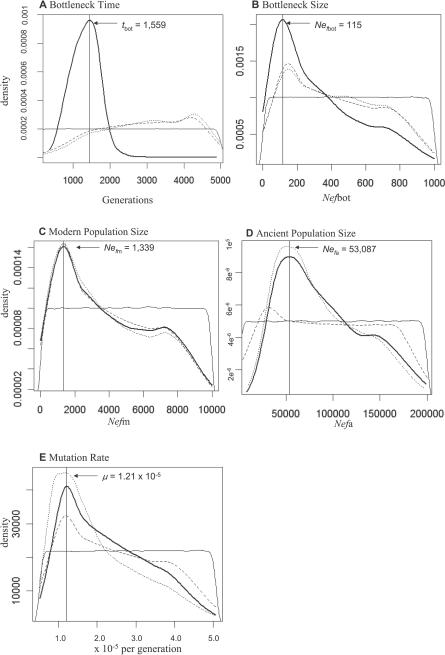
Posterior Density Curves of Model Parameters Based on 1,000 Accepted Values from 1,000,000 Iterations of the Bottleneck ModelThick black line is the posterior density curve of the bottleneck model which includes multiple time points, dashed line is the posterior based on modern data only, and dotted line is the posterior based on two time points, modern and ancient. The mode is indicated with a vertical line and labeled. Thin line is the prior density curve based on 1 million simulated values.(A) Bottleneck time in generations. Assuming a 2-y generation time the peak of the posterior density curve is at 3,118 ybp. Only multiple time points allow reasonable estimation of the bottleneck time.(B) Bottleneck size.(C) Modern population size.(D) Ancient population size. The modern data alone do not provide an estimate the ancient population size; however, with two time points, an estimate of the magnitude of the decline from the ancient population size is possible.(E) Mutation rate expressed as mutations per 253-bp region per generation.